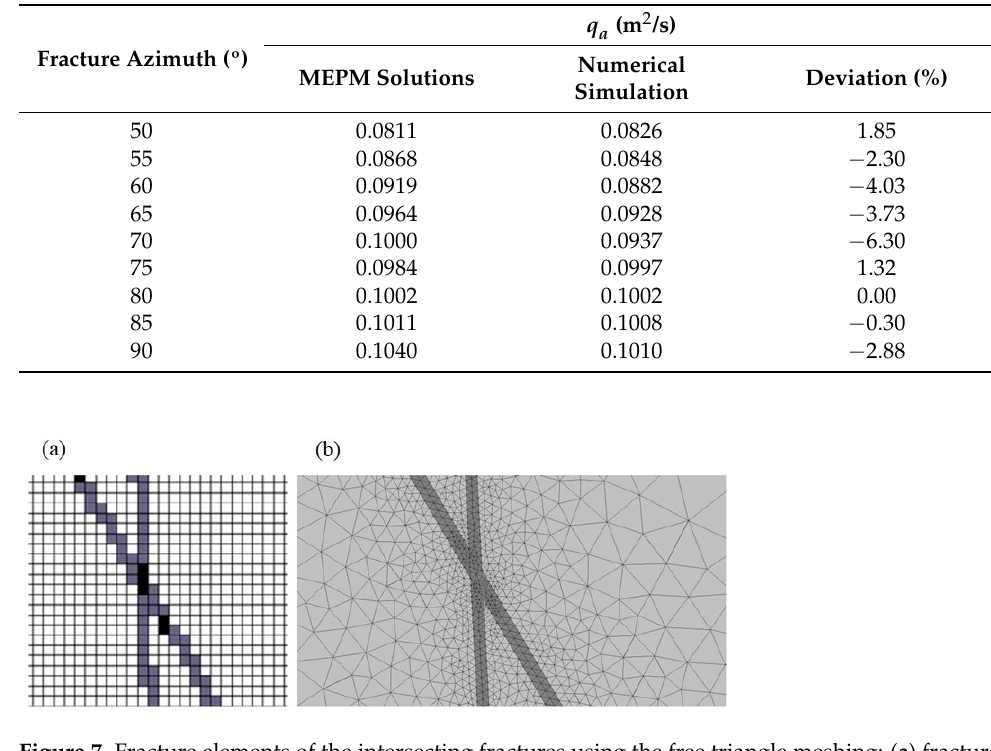
Figure 7. Fracture elements of the intersecting fractures using the free triangle meshing: ( a ) fracture elements after space discretization [63]; ( b ) free triangle meshes used in this study.